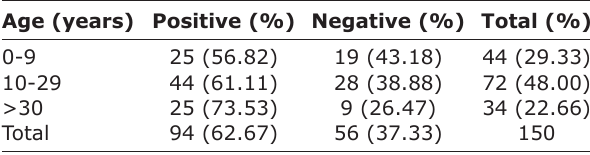
Table-4: Age distribution of Campylobacter isolates in human fecal samples from Zuru Kebbi State.